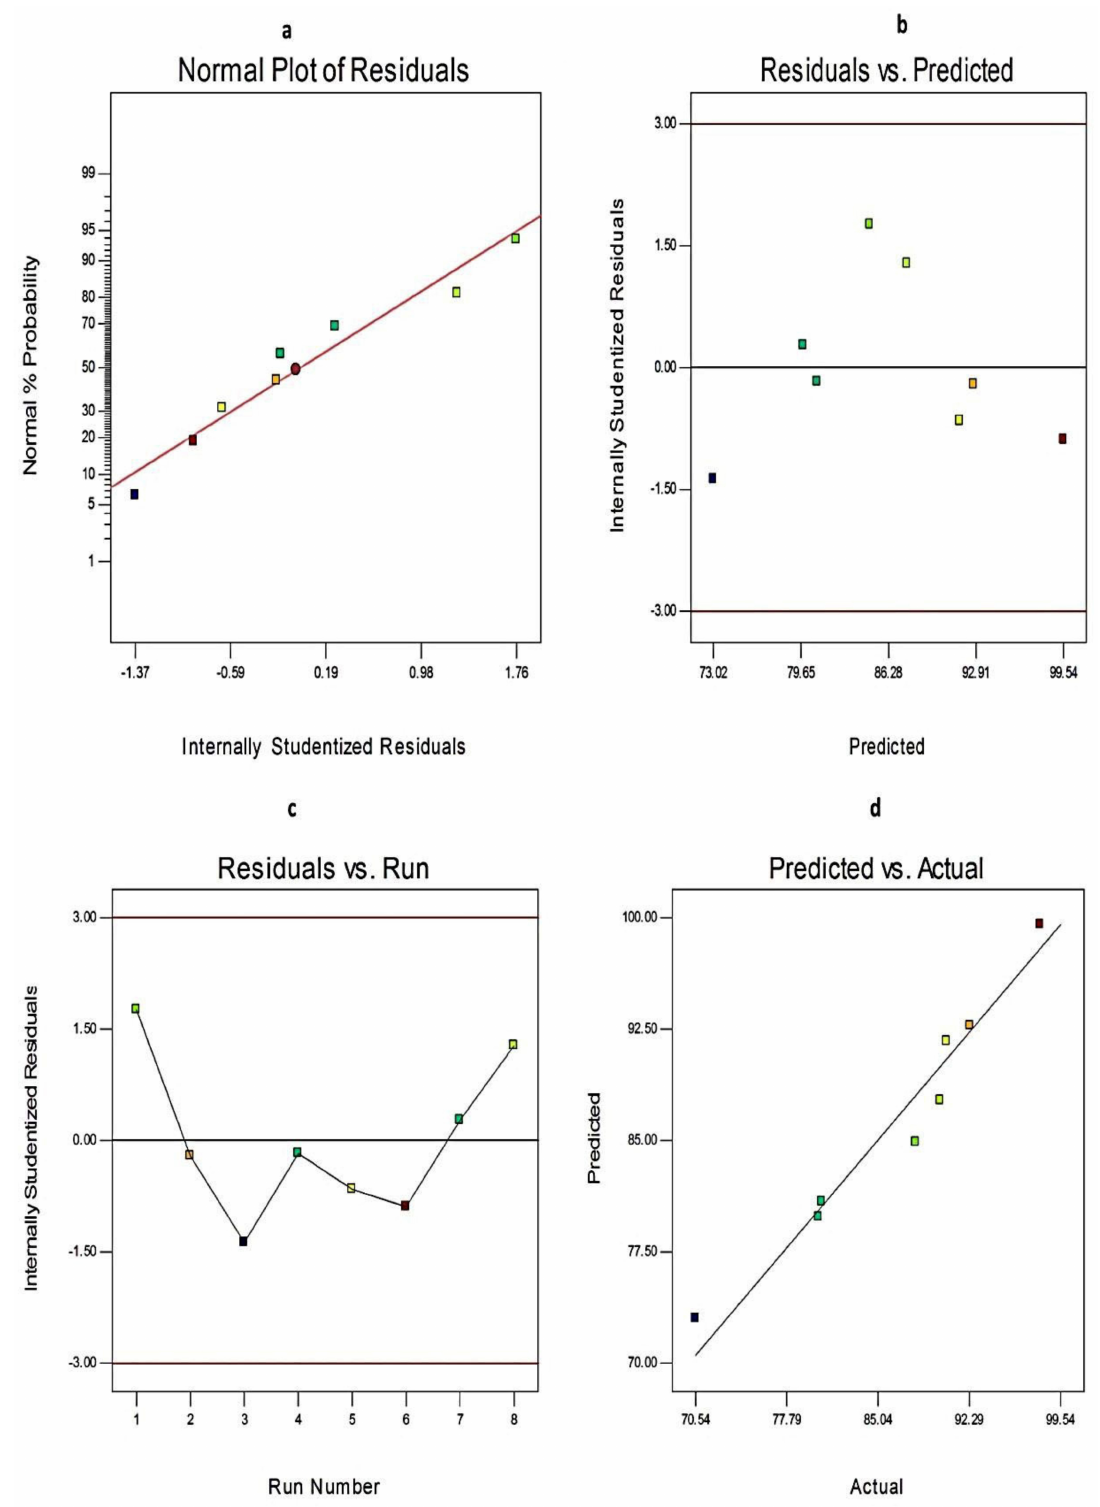
Figure 2. The diagnostic plots for EE% of EGCG-loaded spanlastics ( a ) plot of normal % probability versus the internally studentized residuals, ( b ) plot of the internally studentized residuals versus the predicted values, ( c ) plot of the internally studentized residuals versus the run number, and ( d ) plot of the predicted versus the actual values of EE%. Abbreviation: EE, entrapment efficiency of EGCG-loaded